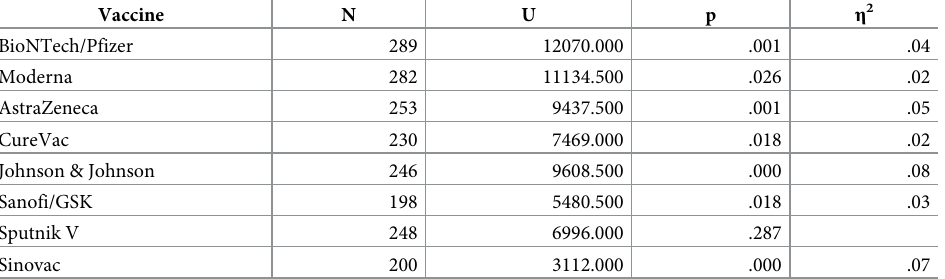
Table 2. Summary of Mann-Whitney U tests examining differences between the control and treatment group for each COVID-19